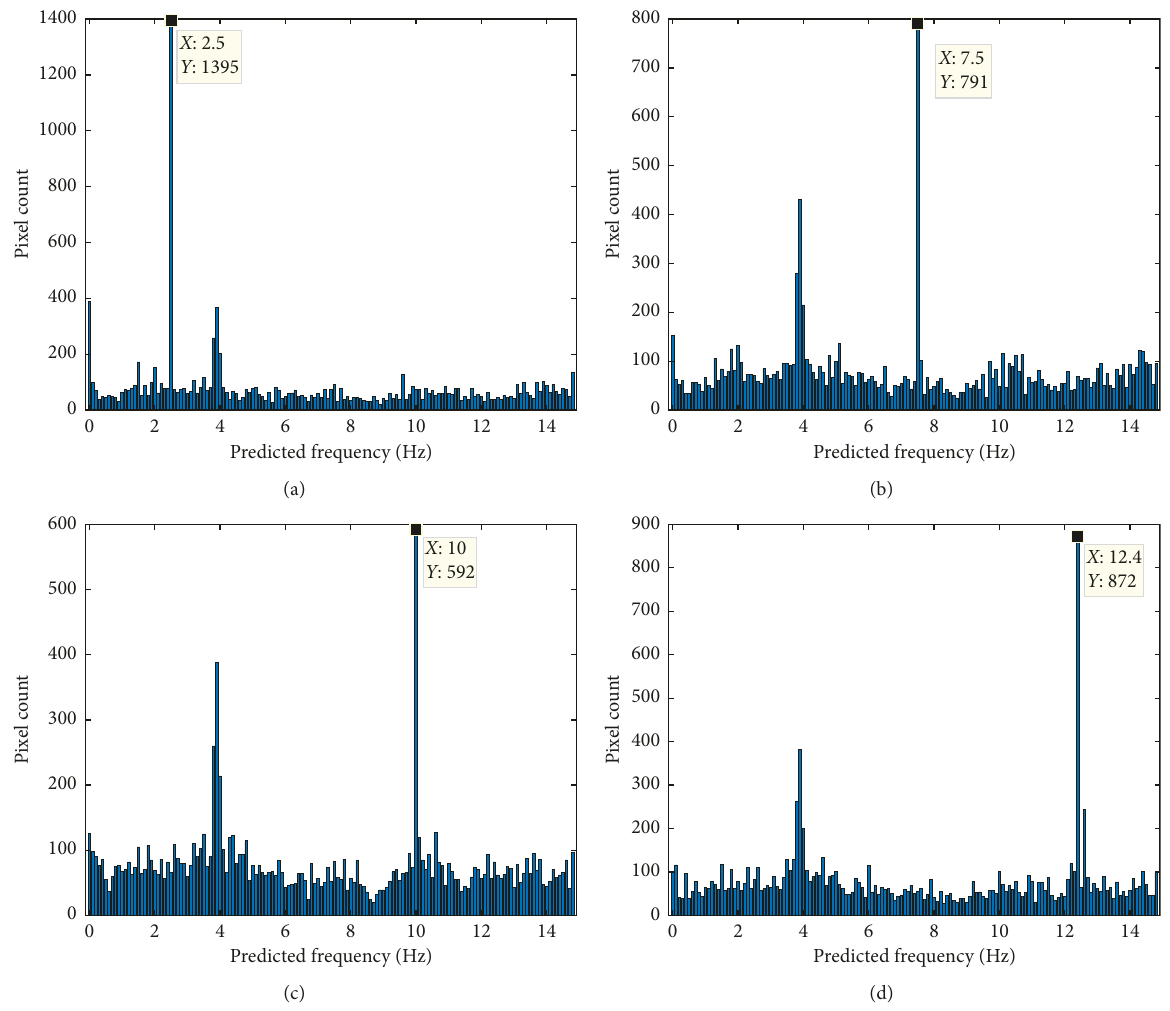
Figure 16: Histogram of predicted frequency distribution from the verification test. Results at different excitation frequencies: (a) 2.5Hz; (b) 7.5Hz; (c) 10 Hz; (d)